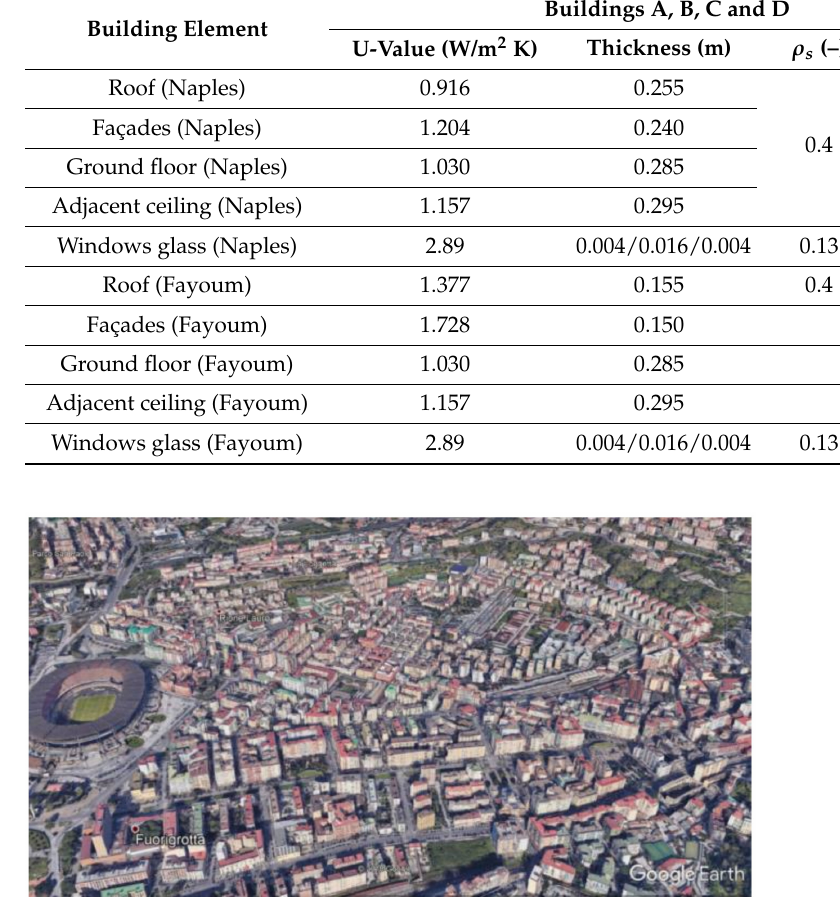
Figure 3. Crowded residential